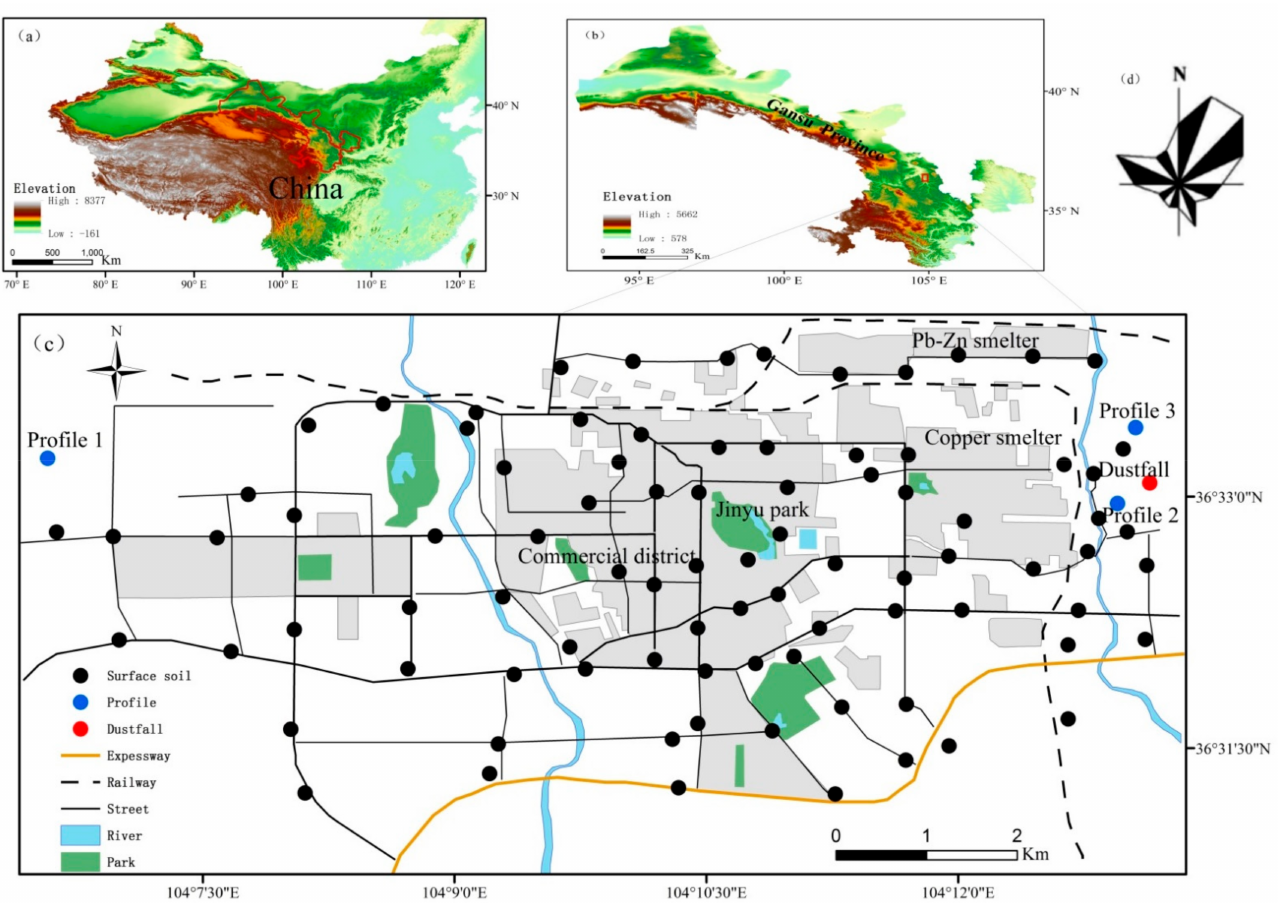
Figure 1. ( a ) Location of Gansu province in China; ( b ) Location of Baiyin city in Gansu province; ( c ) Sketch map of the study area; ( d ) Wind direction rose map of